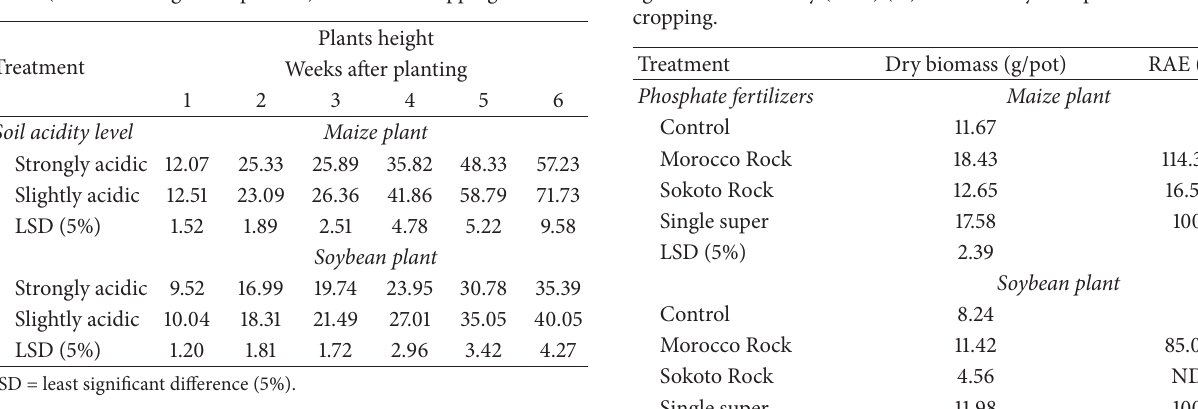
Table 2: Influence of soils on heights (cm) of maize and soybean plants (at successive growth periods) in the first cropping.